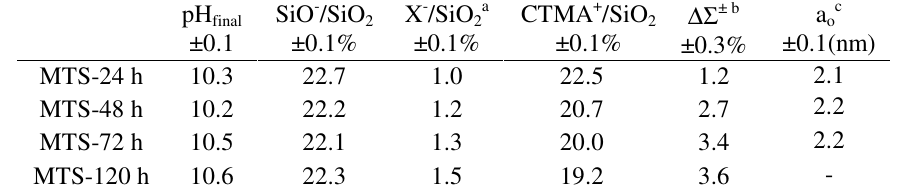
Table 1. Chemical analysis of as-made silica mesophase obtained with titration of 0.1N HCl in absolute ethanol